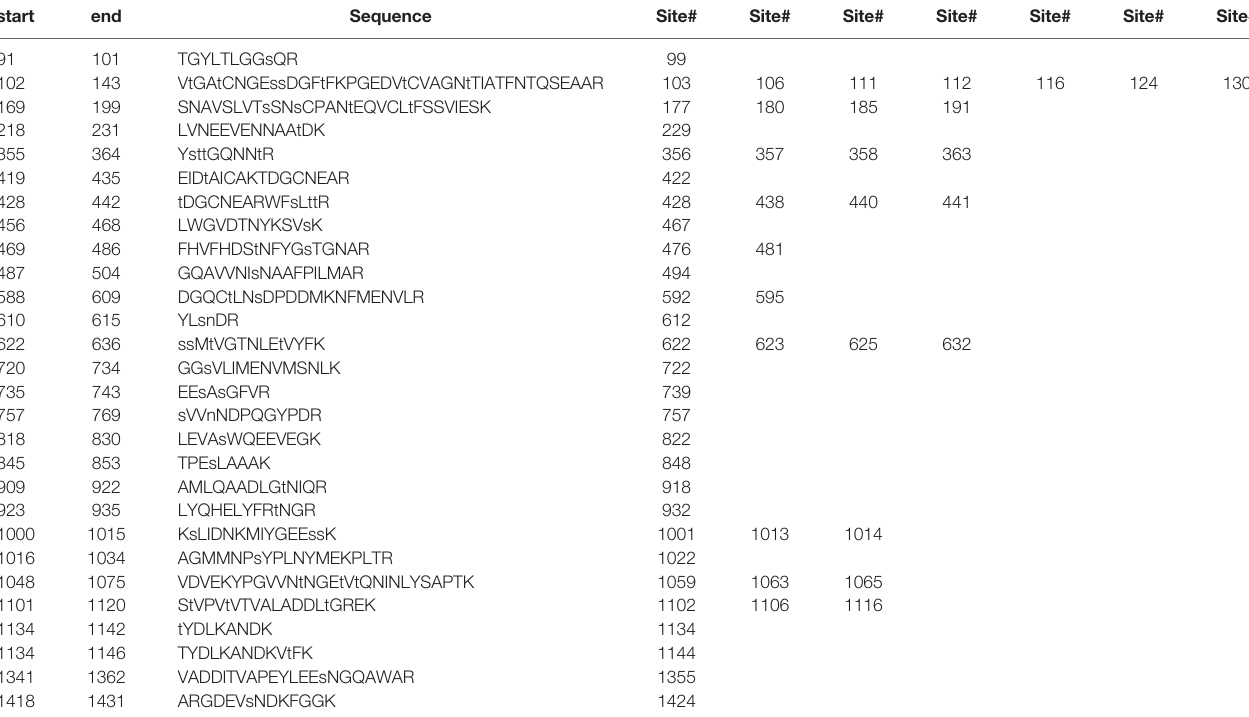
TABLE 1 | BEMAP analysis of glycosylated YghJ. YghJ was digested with Trypsin and O-linked glycosylated peptide sequences were identi fi ed using BEMAP in combination with mass